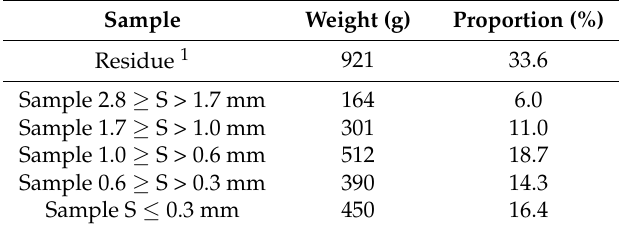
Table 2. Weight analysis of the different sizes of crushed glass pieces.